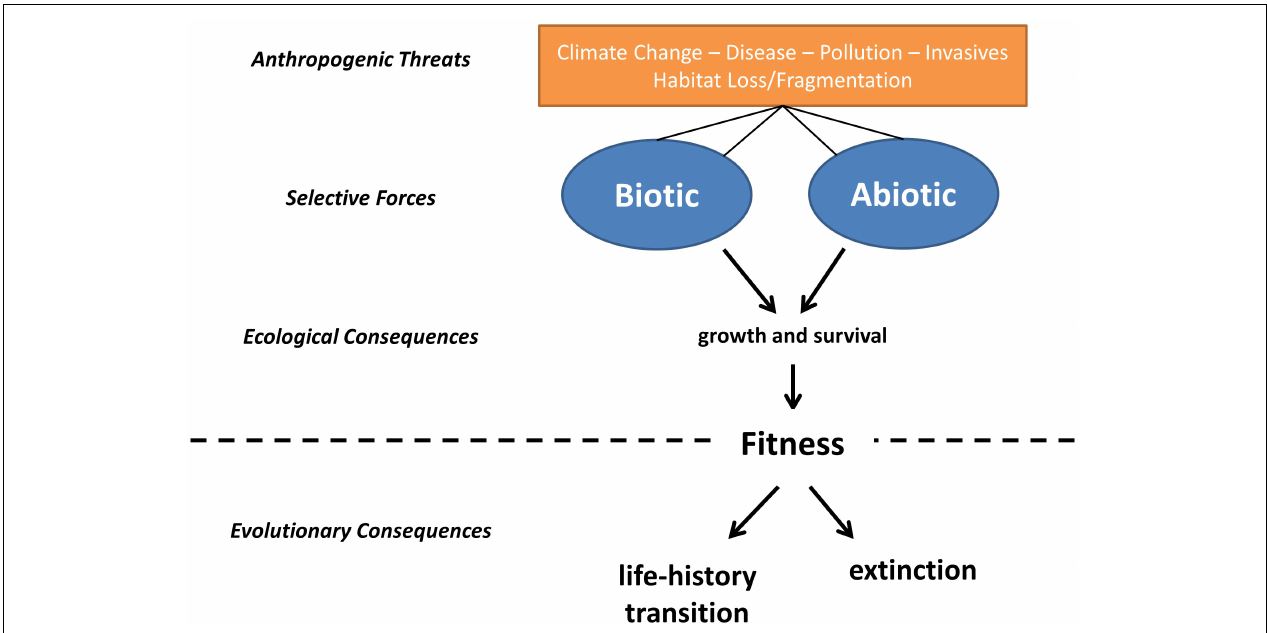
FIGURE 1 | The predicted consequences of anthropogenic stressors on the selection of life-history strategies, adapted from Southwood (1988). The strategy selection system assumes life history strategies are shaped by particular characteristics of a given environment, such that if anthropogenic change alters the abiotic and biotic pressures experienced in that environment, a new optimal life-history strategy will emerge. In the context of amphibian life-histories, changes that disproportionately impact aquatic or terrestrial environments will select for the elimination of the aquatic or terrestrial phase in a life-cycle and/or render species with particular life histories more vulnerable to